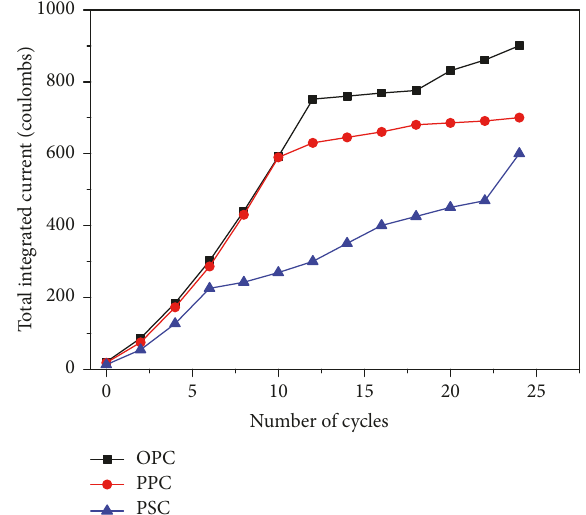
Figure 13: Macrocell current versus number of cycles of exposure for rebar in OPC, PPC and PSC M40 grade concrete types (90 days cured specimens) under macrocell condition.